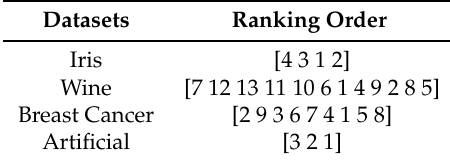
Table 5. Feature ranking using APDI.